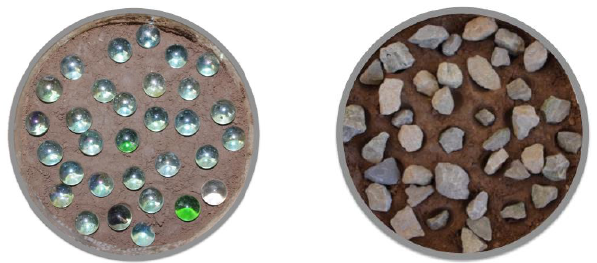
Figure 1. Preparation of disturbed samples containing glass balls (left panel) and gravels (right